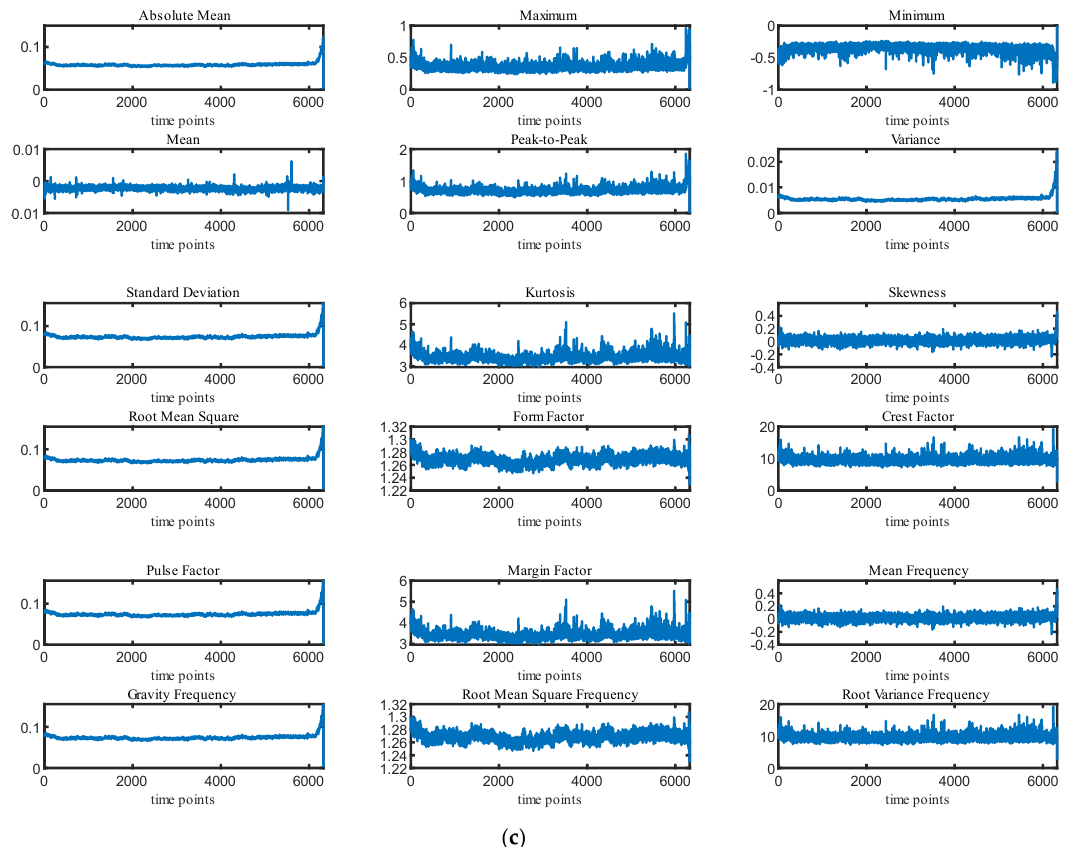
Figure 8. ( a ) Feature extraction results of Br1-3; ( b ) feature extraction results of Br2-1; ( c ) feature extraction results of Br3-3.